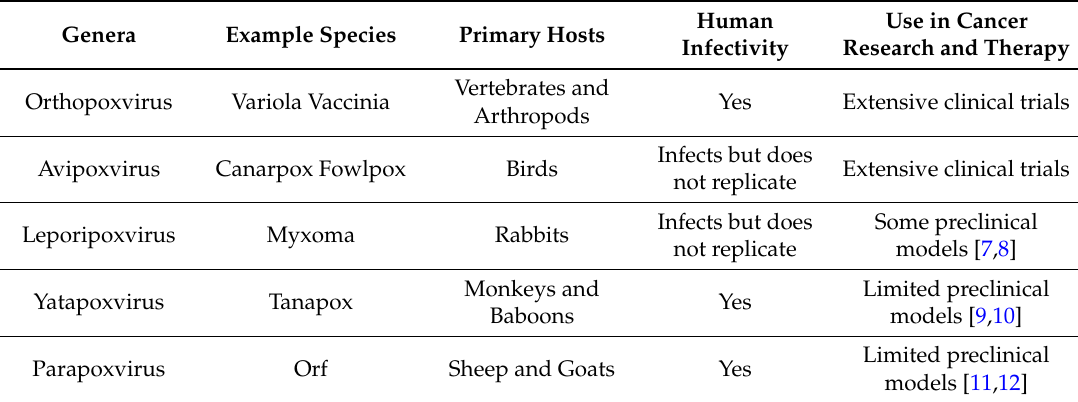
Table 1. Example